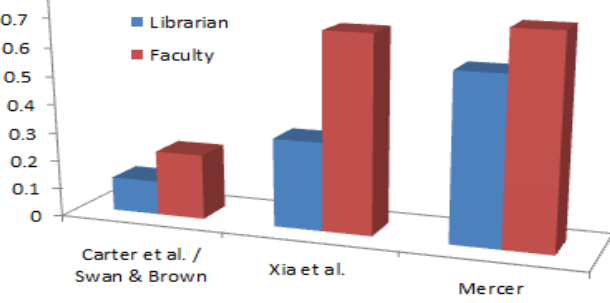
Figure 4. The OA divide between librarians and faculty in self-archiving